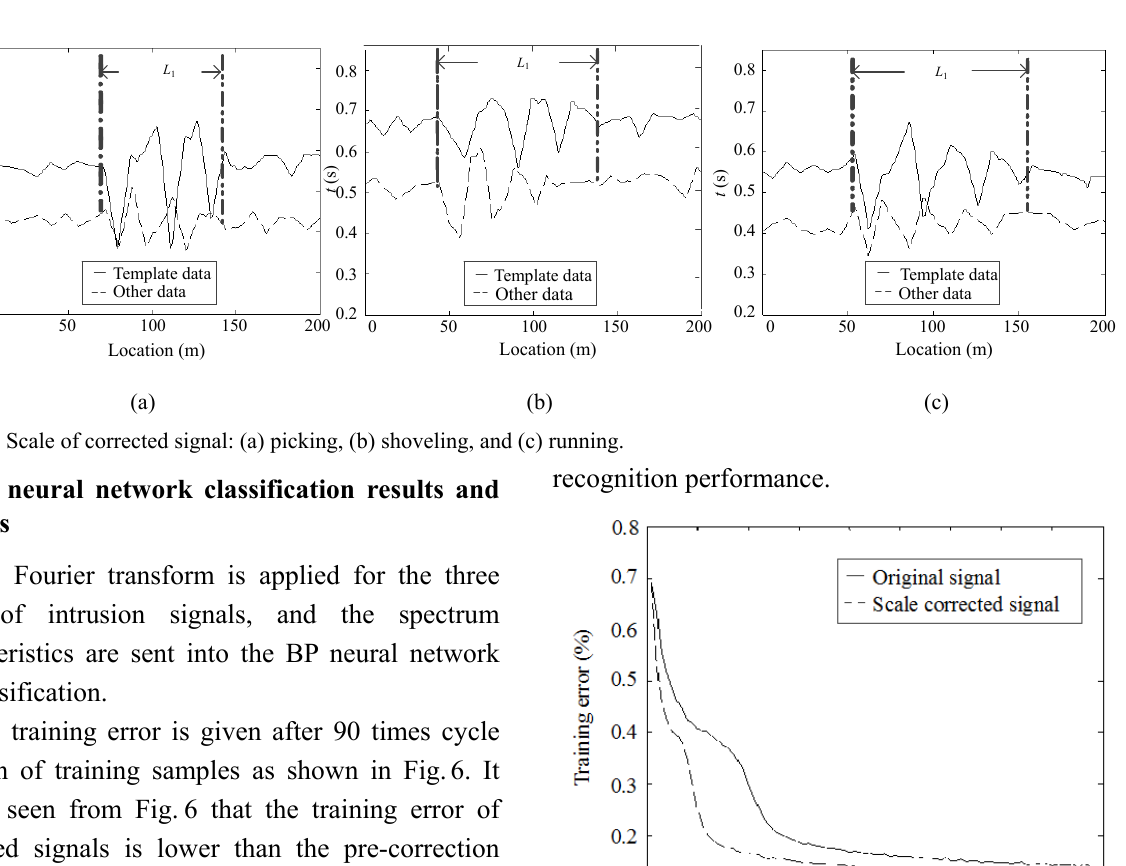
Fig. 4 Scale of pre-correction signals: (a) picking, (b) shoveling, and (c) running.